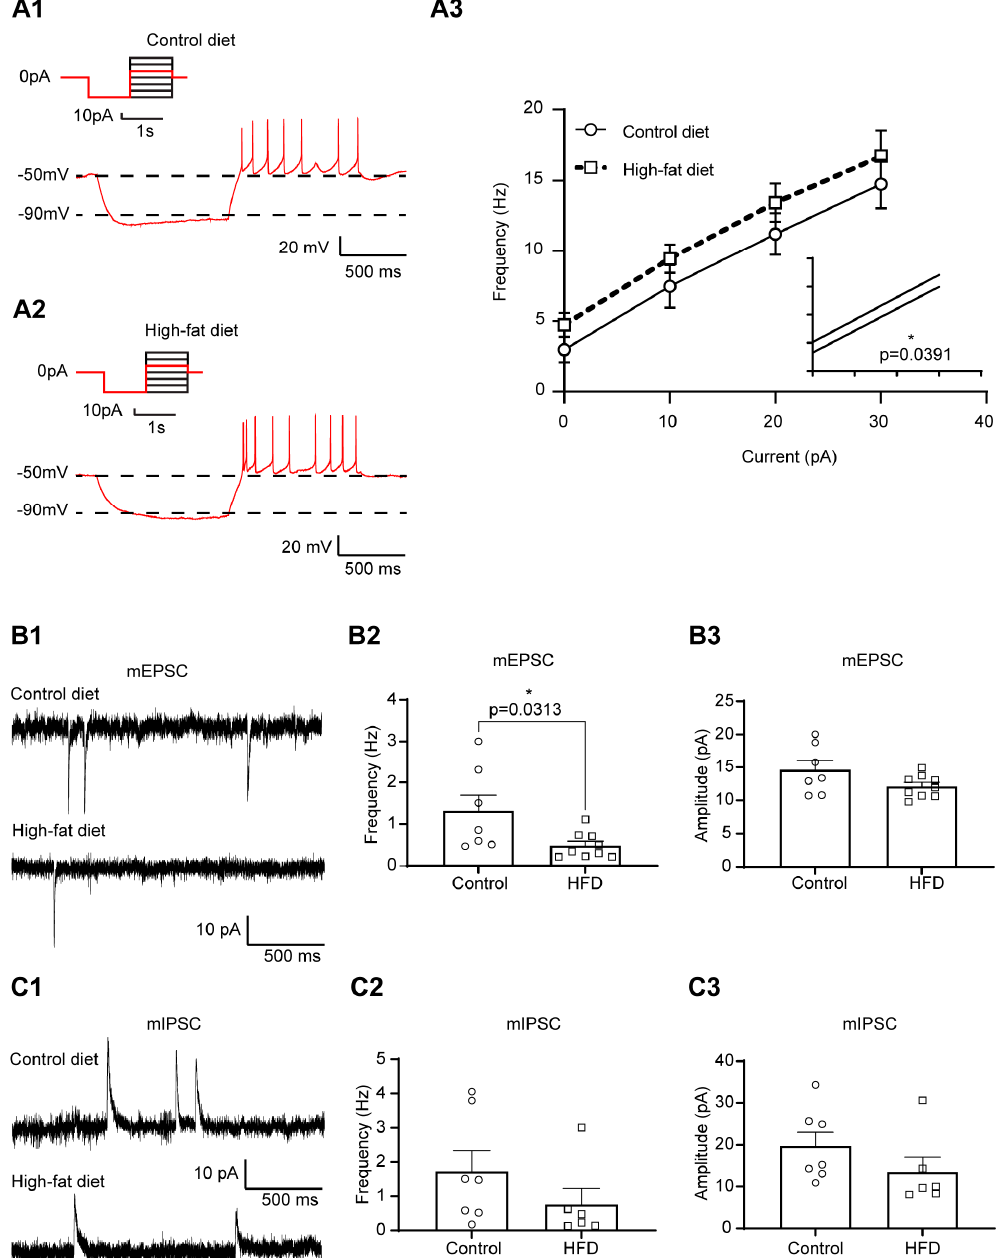
Figure 1. The excitability of liver-related PVN neurons increased in mice kept on HFD. ( A1 , A2 ): Representative traces illustrate the firing rate of liver-related PVN neurons. The recorded neurons were initially hyperpolarized to ~ − 90 mV, then depolarizing current steps were applied to reveal the firing activity in control ( A1 ) and HFD-fed ( A2 ) mice. Whereas multiple current steps were applied, only one trace (+10 pA) is shown for better visibility. ( A3 ): Current–action potential frequency curves and computed simple linear regression demonstrated that liver-related PVN neurons fire more in HFD-fed mice. ( B1 ): Representative recordings of mEPSCs in liver-related PVN neurons of control (upper trace) and HFD-fed (lower trace) mice. ( B2 , B3 ): Bar graphs illustrate that the frequency of mEPSCs ( B2 ) was decreased in HFD-fed mice, whereas the amplitude of mEPSCs was similar ( B3 ). ( C1 ): Representative traces of mIPSCs in liver-related PVN neurons from control (upper trace) and HFD-fed (lower trace) mice. There was no di ff erence in the frequency ( C2 ) and amplitude ( C3 ) of mIPSCs. HFD: high-fed diet, mEPSCs: miniature excitatory post-synaptic currents, mIPSCs: miniature inhibitory post-synaptic currents. Circles and squares represent individual neurons. * p < 0.05.